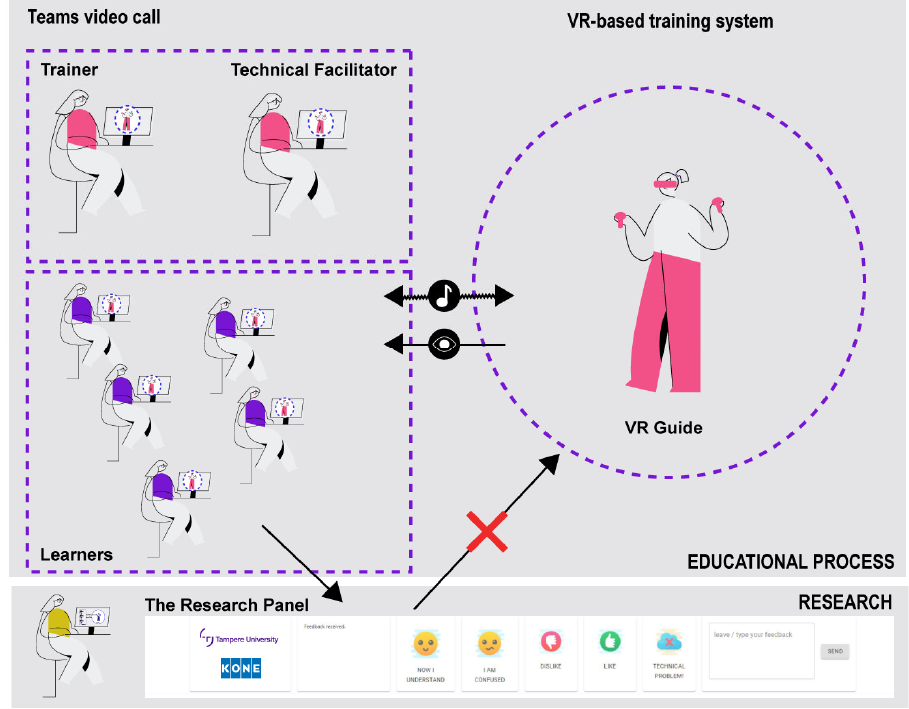
Figure 3. Asymmetric set ‐